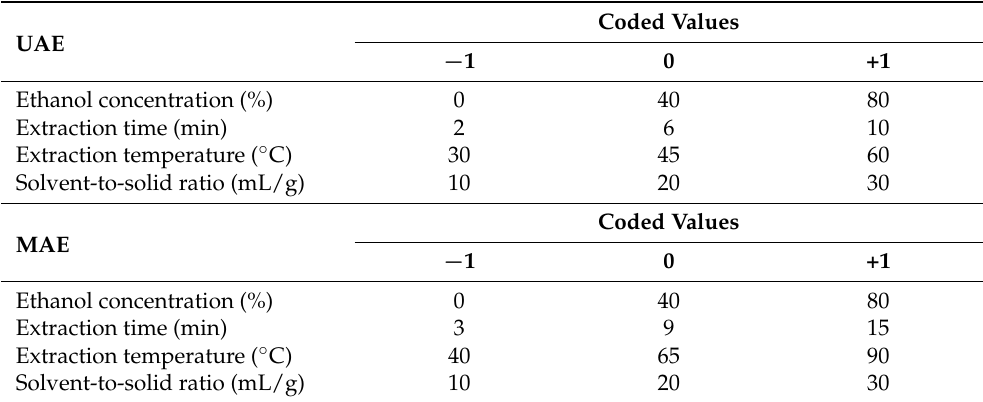
Table 1. Coded and actual levels of the independent variables used for ultrasound-assisted extraction (UAE) and microwave-assisted extraction